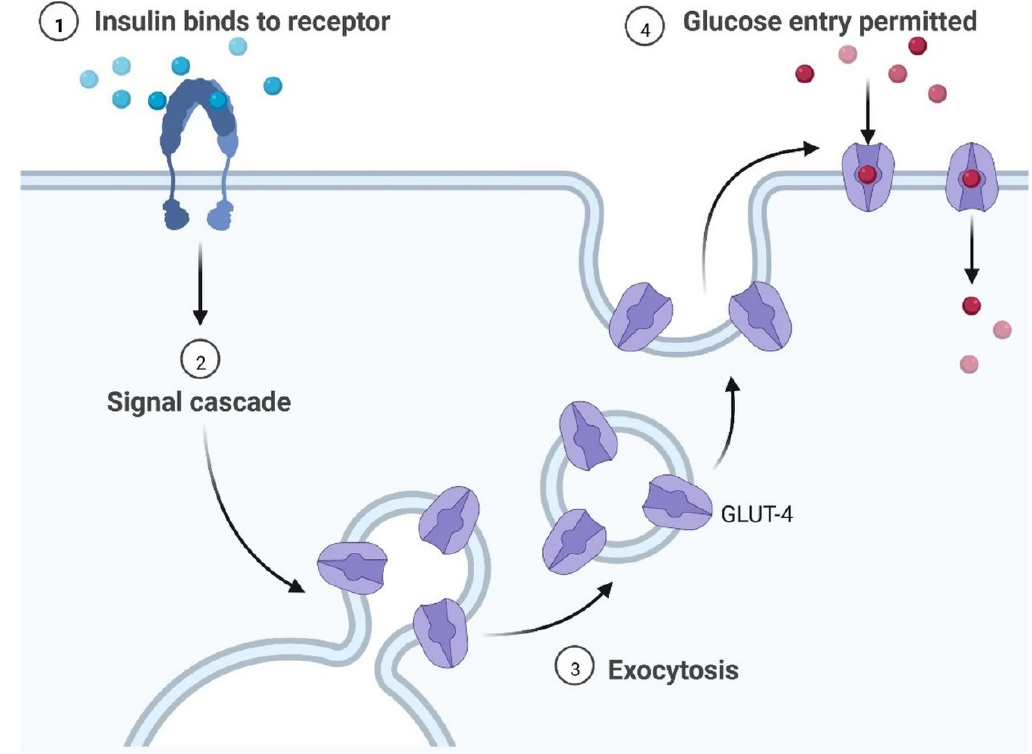
Figure 5. Key steps of the insulin signaling pathway, including insulin binding, signal cascade, exocytosis, and glucose entry. The regulation of signal transduction pathways depends on the signaling of extracellular chain reactions; each response is based on the course of signaling requirements. Glucose is taken up in adipose tissue and muscles via the GLUT 2 receptors in pancreatic beta cells and liver cells, with enhanced diffusion at GLUT 4 receptors. GLUT 1 and GLUT 2 allow glucose to reach cells, including the brain, retina, kidney, RBC, and other parts of the body.